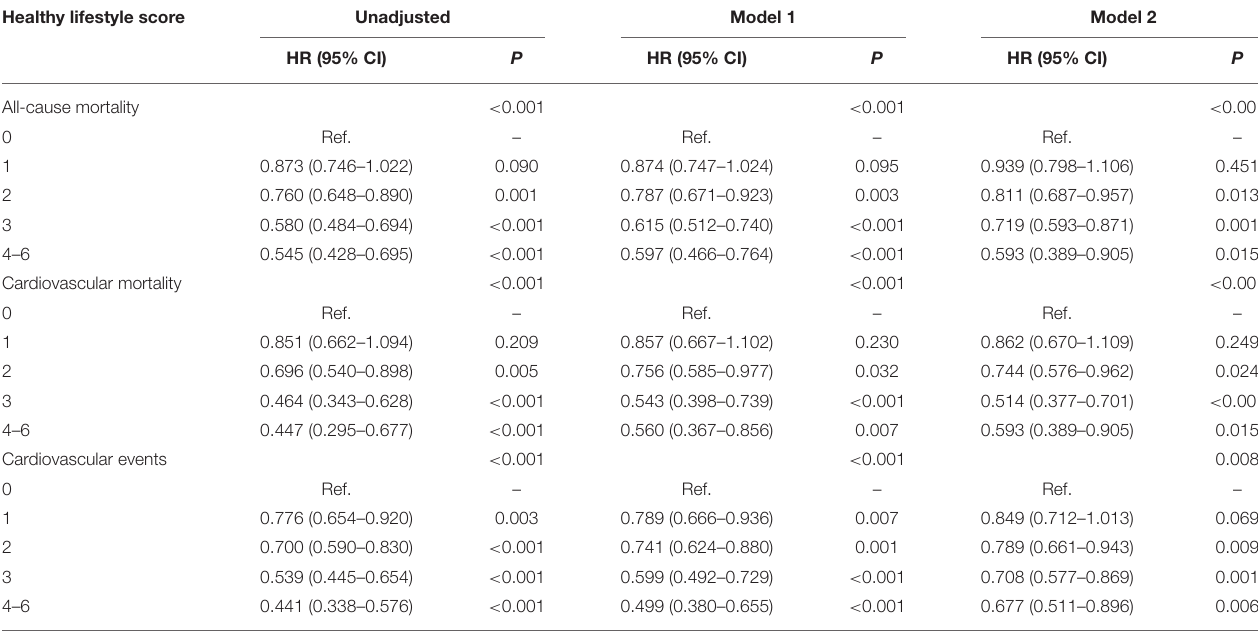
TABLE 2 | Adjusted hazard ratios for the association of healthy lifestyle score with all-cause mortality, cardiovascular mortality, and cardiovascular events. Healthy lifestyle score Unadjusted